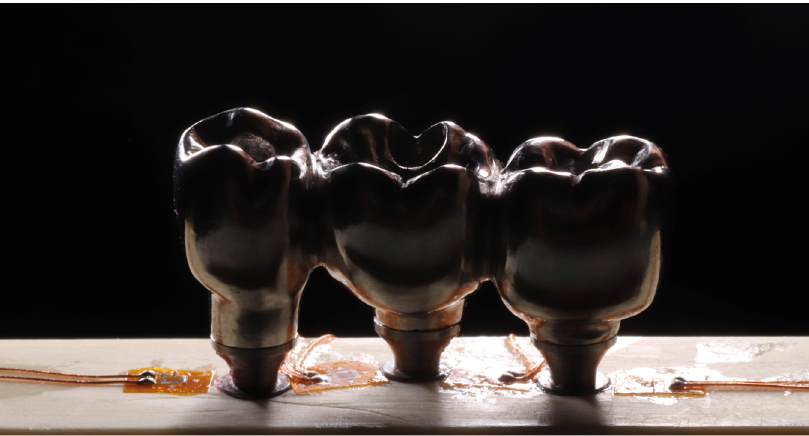
Figure 11. Positioning of four strain gauges on the surface of a polyurethane